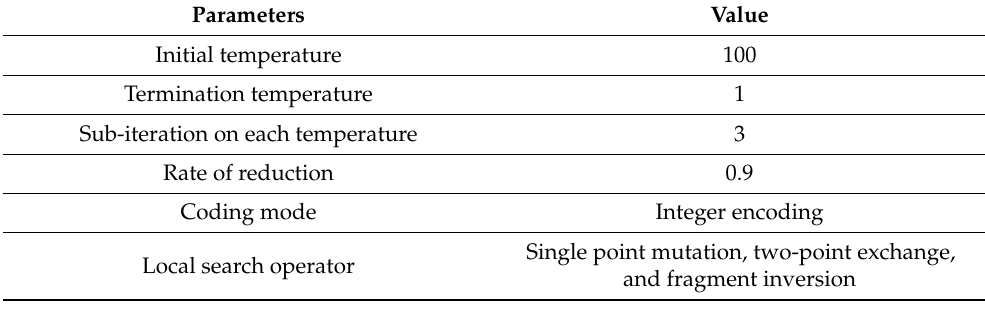
Table 9. The parameters in ISA.